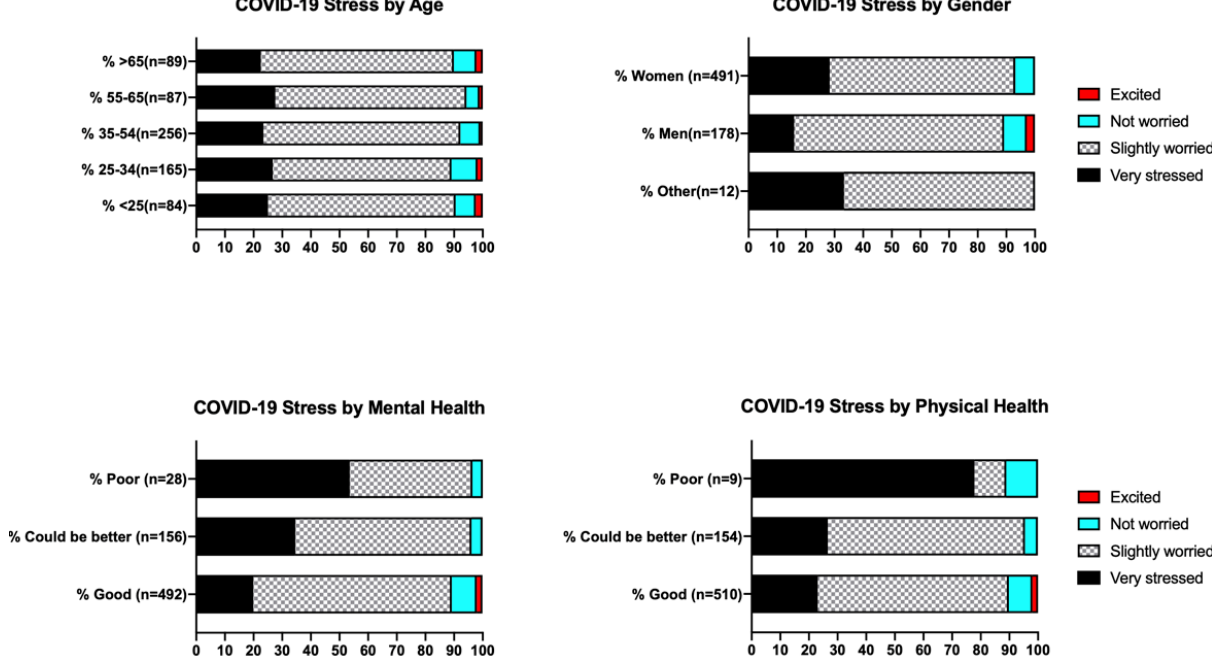
Figure 2. Perceptions of COVID-19 stress across age, gender, and self-assessed health groups. COVID-19: coronavirus